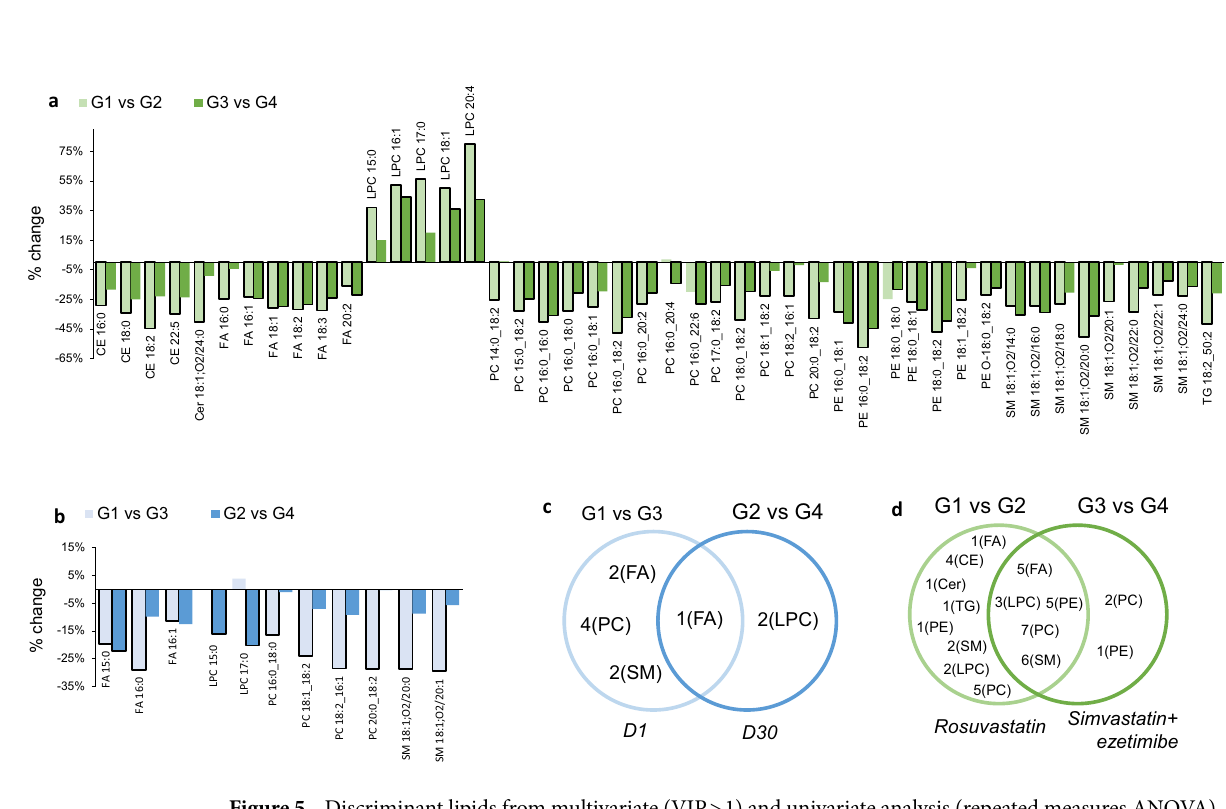
Figure 5. Discriminant lipids from multivariate (VIP > 1) and univariate analysis (repeated measures ANOVA). ( a ) % change of metabolites considering the temporal treatment effect (*metabolite statistically significant are highlighted with black borders); ( b ) % of change of metabolites considering the lipid-lowering therapy effect (*metabolite statistically significant are highlighted with black border); ( c ) Venn Diagram considering lipid- lowering therapy; ( d ) Venn Diagram considering temporal treatment effect. Figure was created in Microsoft Excel 2013 (URL: https:// www. micro soft. com/ pt- br/ micro soft- excel- 2013) and Microsoft PowerPoint 2013 (URL: https:// www. micro soft. com/ pt- br/ micro soft- power point-